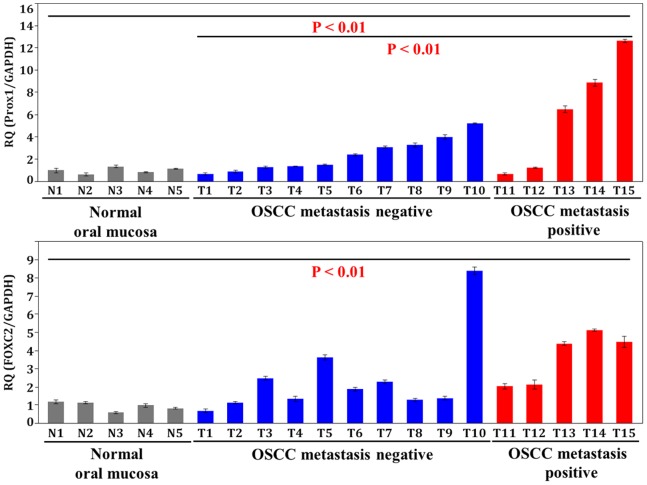
Gene expression of Prox1 and FOXC2 by qRT-PCR.The mRNA expression levels of Prox1 (P<0.01) and FOXC2 (P<0.01) in OSCCs were higher than normal oral mucosa. Prox1 expression was upregulated in nodal metastasis positive OSCCs than in those with negative OSCCs (P<0.01). GAPDH was used for internal control. Error bar, standard deviation (S.D.).